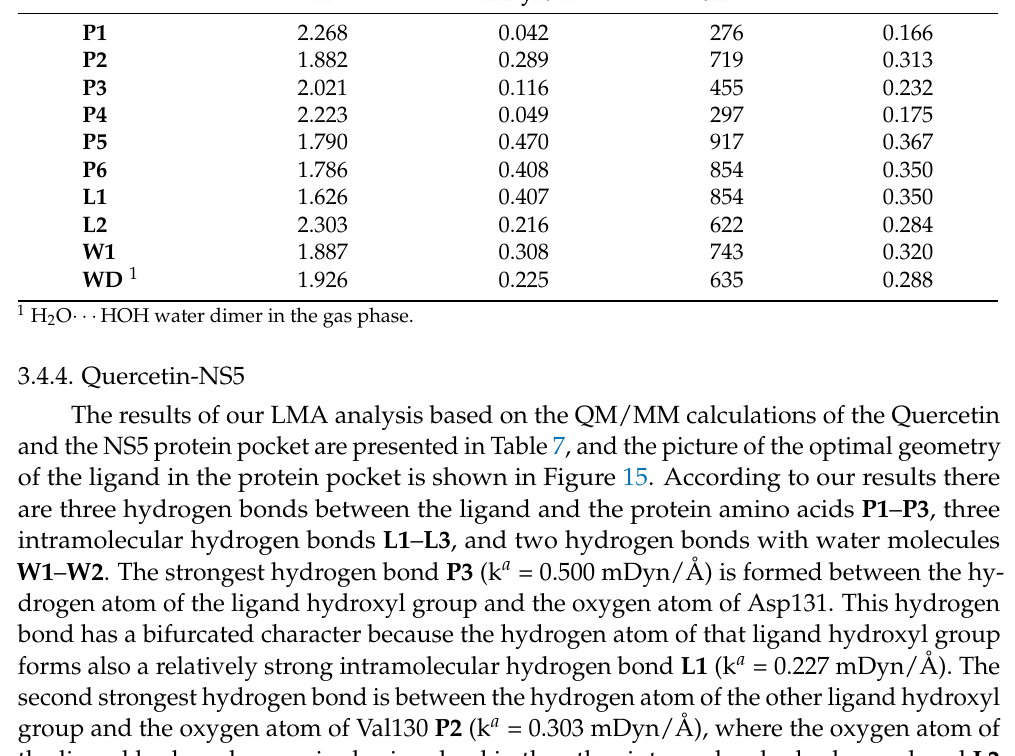
Figure 14. Hydrogen bonds in the Quercetin-NS3 complex (dashed lines). Bond lengths are shown in the normal font, BSO values are shown in the italic font. ω B97X-D/6-31G(d,p)/AMBER level of theory. Table 6. The local mode parameters of the hydrogen bonds between Quercetin and NS3 from the QM/MM calculations, the ω B97X-D/6-31G(d,p)/AMBER level of theory for the calculation in the protein, and the ω B97X-D/6-31G(d,p) level of theory in the gas phase.